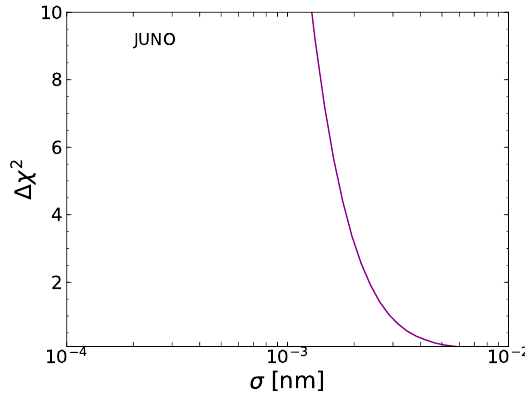
Figure 6 . The reduced (cid:31) 2 as a function of (cid:27) relative to its minimum value, obtained by analyzing simulated JUNO data consistent with no decoherence ( (cid:27) ! 1 ) and marginalizing over the remain- ing four neutrino oscillation parameters. The input values for the standard oscillation parameters are listed in eqs.